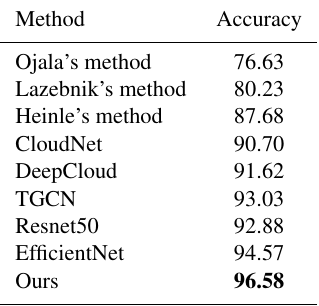
Table 4. Comparison of results of different methods.